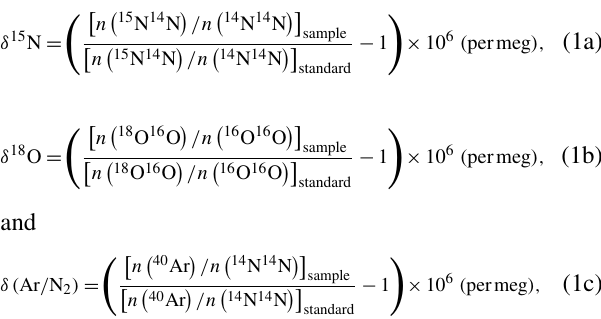
and SF 6 mole fractions using a nondispersive infrared gas an- alyzer (NDIR) and a gas chromatograph (GC) equipped with an electron capture detector (ECD),